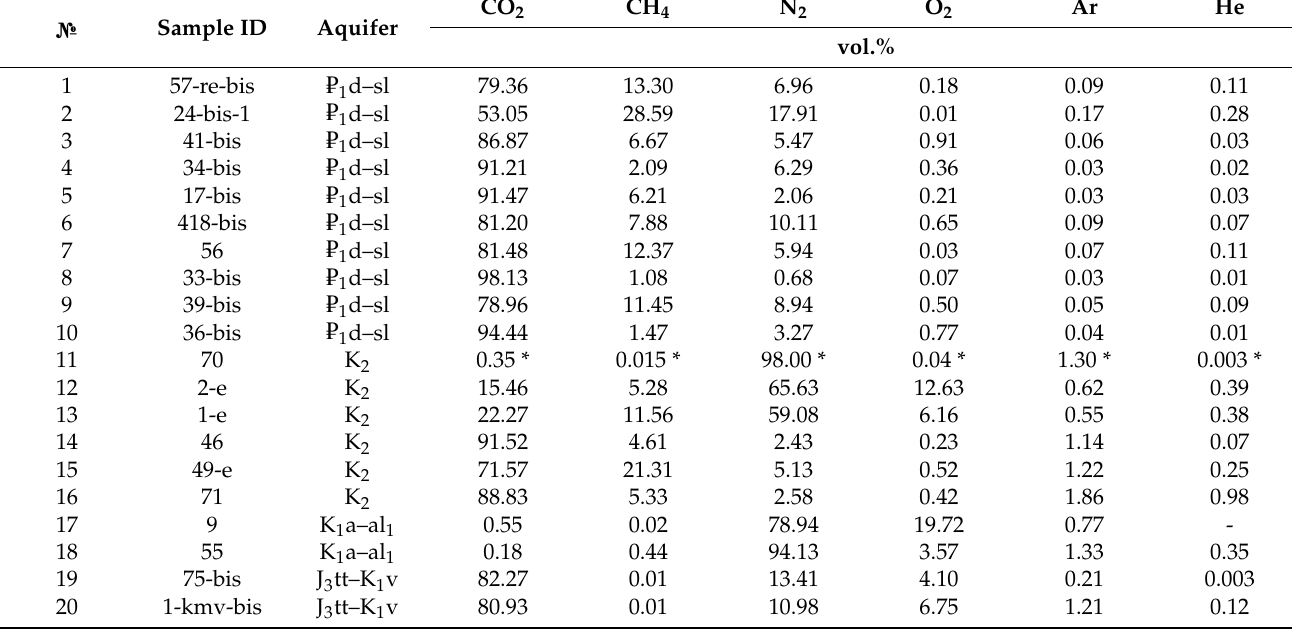
Table 5. Chemical composition of free gases of natural mineral water of the Essentuki field.